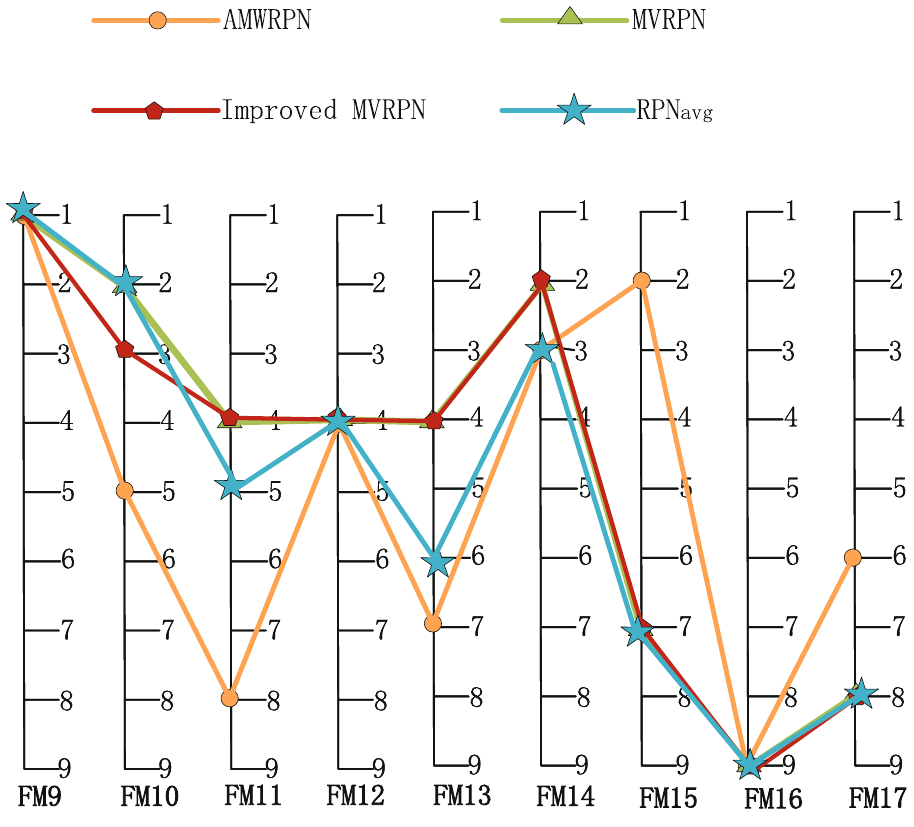
Figure 4. The ranking result of